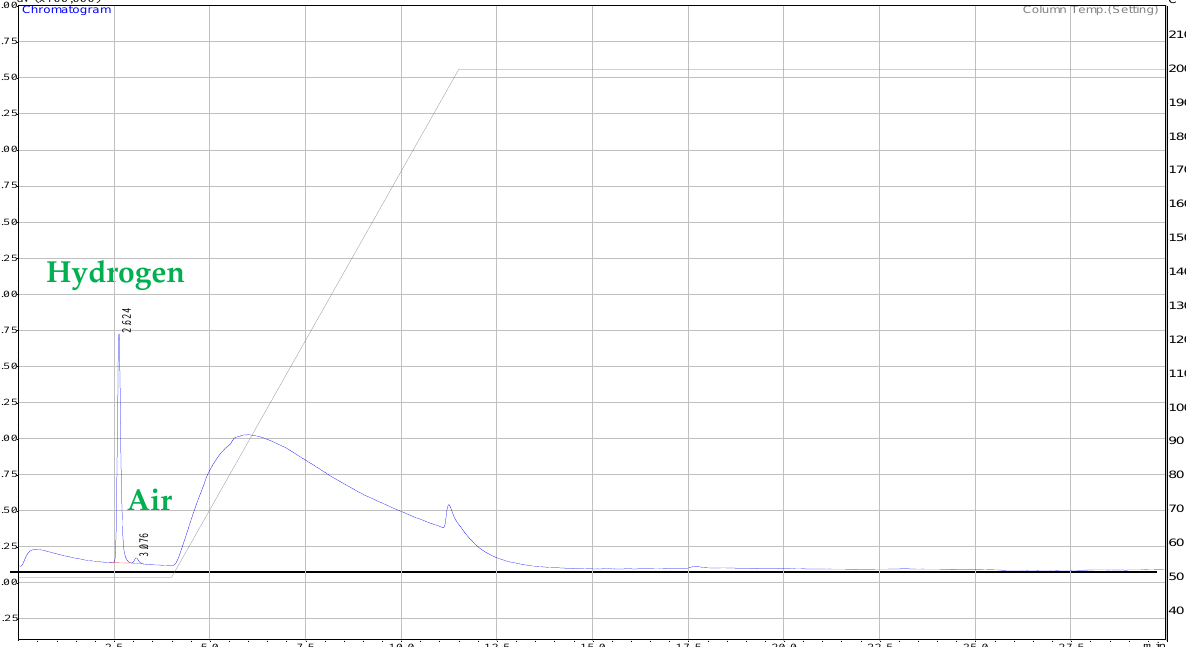
Figure A2. Carbon containing product species peaks as detected by the FID for: ( a ) carbon monoxide (CO), ( b ) methane (CH 4 ), ( c ) carbon dioxide (CO 2 ), ( d ) ethylene (C 2 H 4 ), ( e ) ethane (C 2 H 6 ), ( f ) acetaldehyde (C 2 H 4 O), and ( g ) ethanol (C 2 H 5 OH). H 2 peak measurements were quantified using the TCD calibration, as reported in Figure A3. Calibration was established by using a H 2 certified standard gas mixture sam- ple (10% H 2 and 90% He Praxair), and different known hydrogen volumes (0.1, 0.2, 0.3, 0.4, 0.5, and 0.6 mL). Sample volumes in the syringe were at room temperature, and pres- sure conditions (25 °C and 1 atm). 2.5